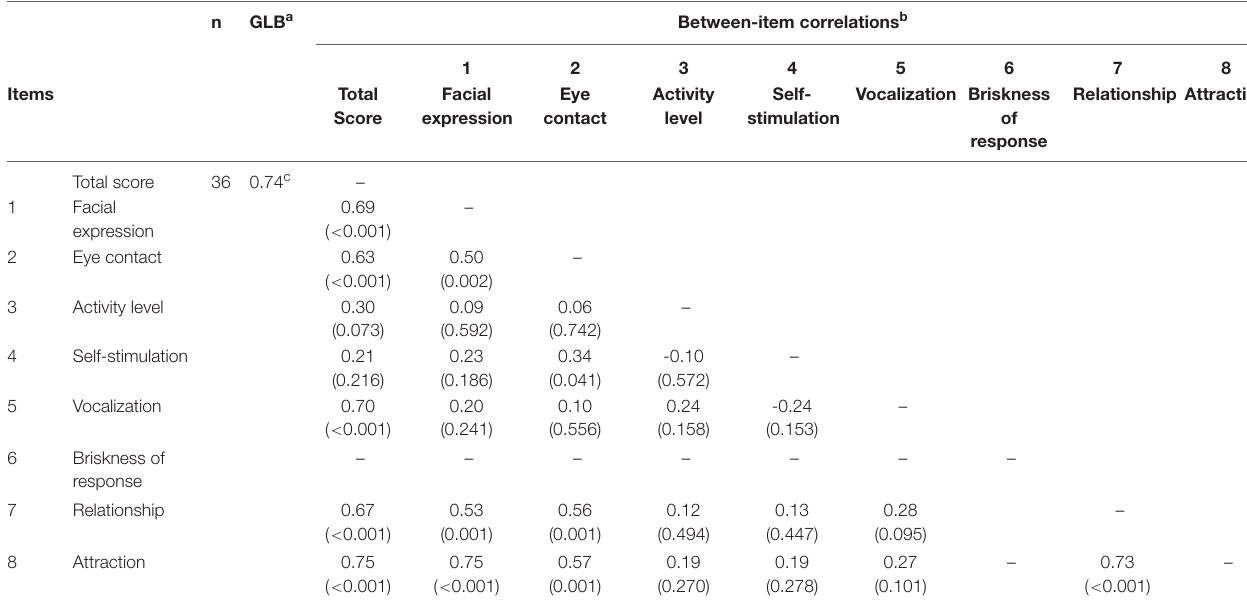
TABLE 4 | Internal consistency of the full Alarm Distress Baby Scale in 36 Nepalese infants.